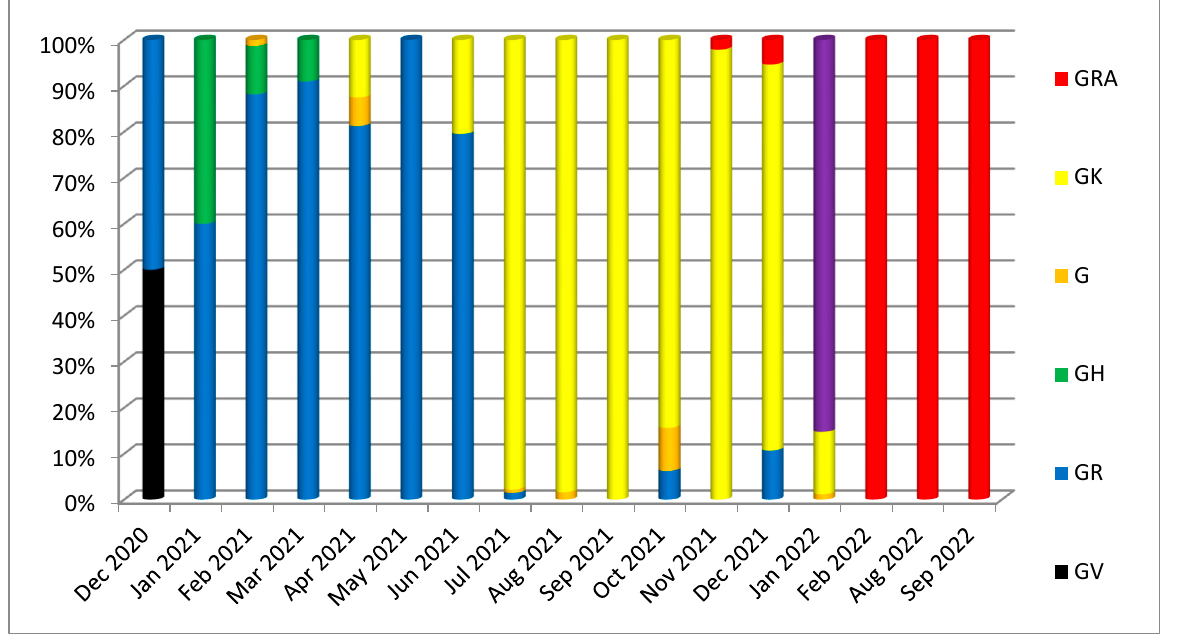
Figure 1. Circulation of SARS-CoV-2 clades in Iraq during five pandemic waves assigned using the GISAID clades.